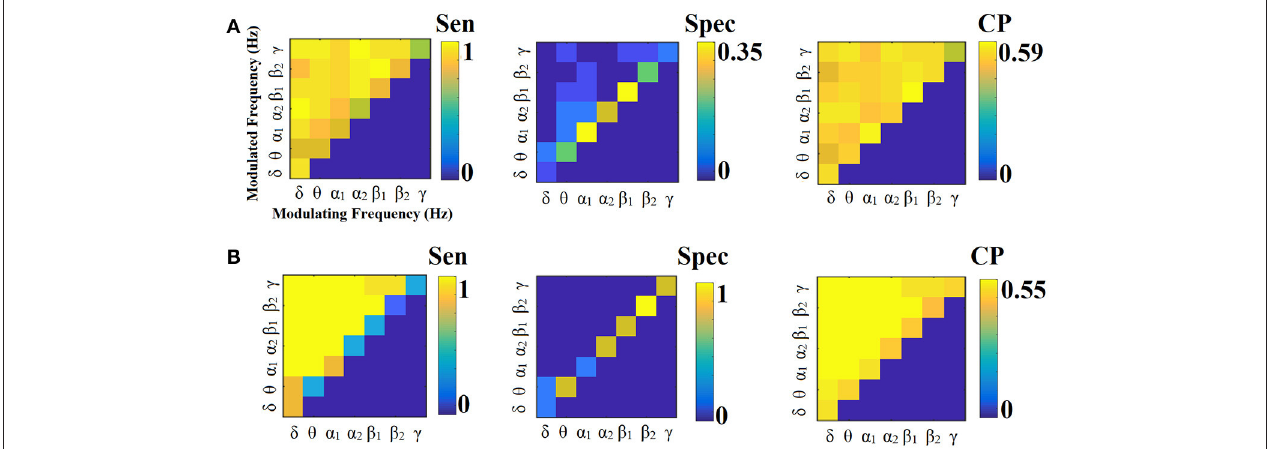
FIGURE 10 | Sensitivity, specificity and classification performance of CorrEnv using Cent ROI representation and tensorial treatment of each SL-FCG. (A) Sensitivity, specificity and classification performance for the LOOCV. (B) Sensitivity, specificity and classification performance for the 5-fold CV. Sen, sensitivity; Spec, specificity; CP, classification performance.